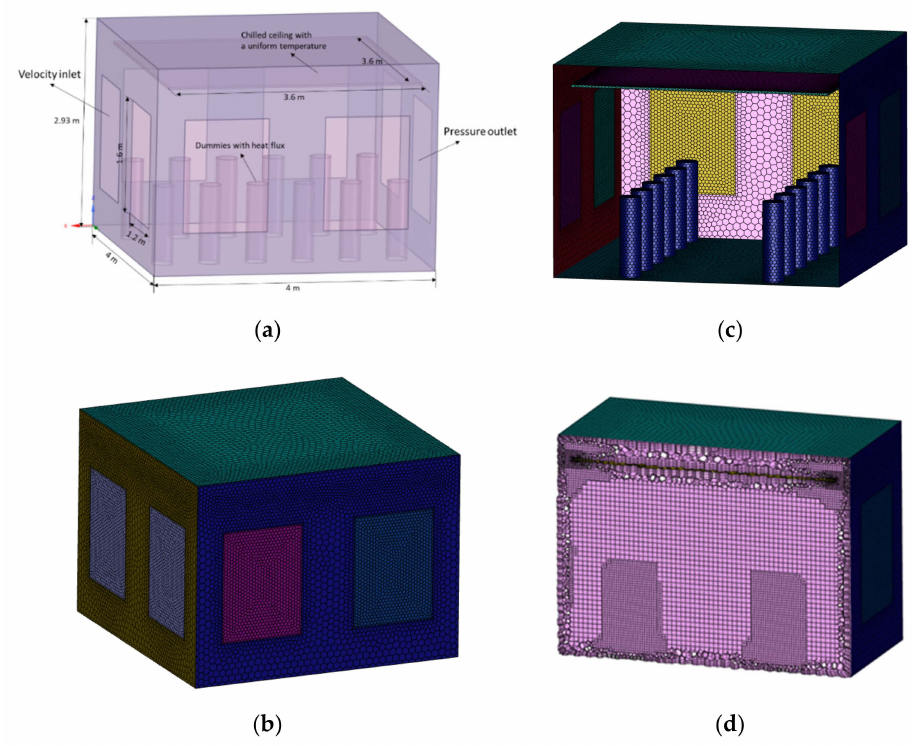
Figure 2. ( a ) Computational domain and dimensions for office model; ( b ) exterior surface mesh; ( c ) interior surface mesh; and ( d ) volume mesh.